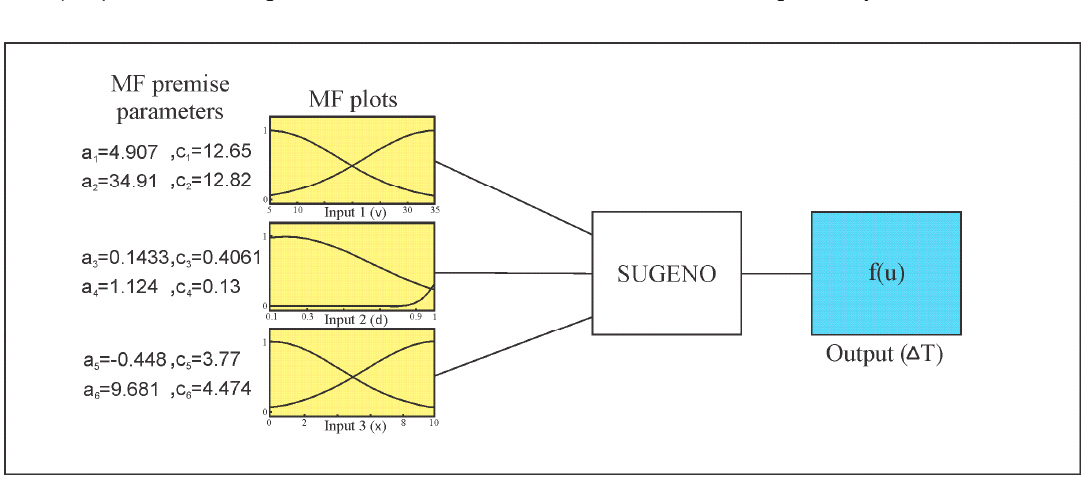
Figure 10. FIS properties of optimized ANFIS (case 2), with all 35 measurements used for training.